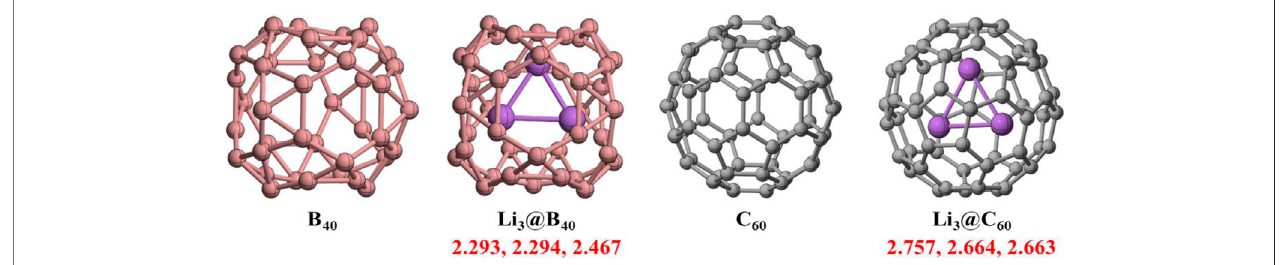
FIGURE1| TheoptimizedgeometriesofB 40 ,C 60 cages,andLi 3 @B 40 andLi 3 @C 60 systemsatBP86-D3/def2-TZVPPmethod.ThevaluesinredcolorindicateLi-Li bond lengths (r Li-Li ). The bond lengths are in the Å unit.